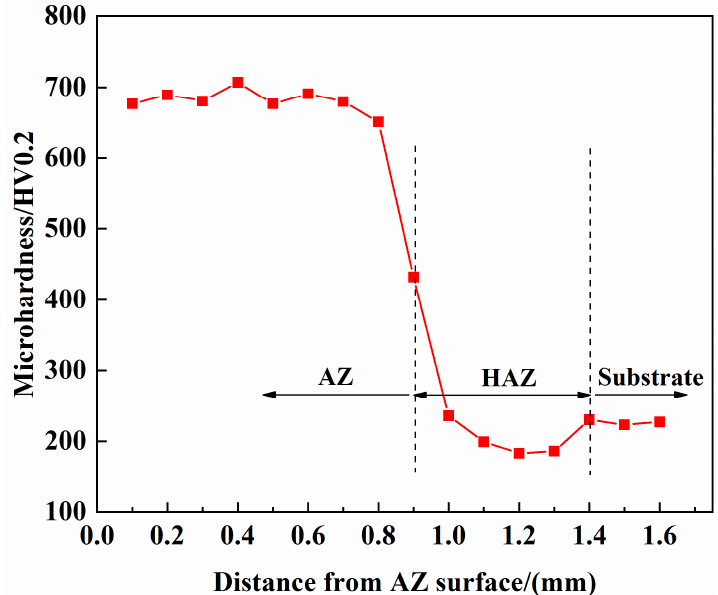
Figure 3. AZ section microhardness distribution curve.